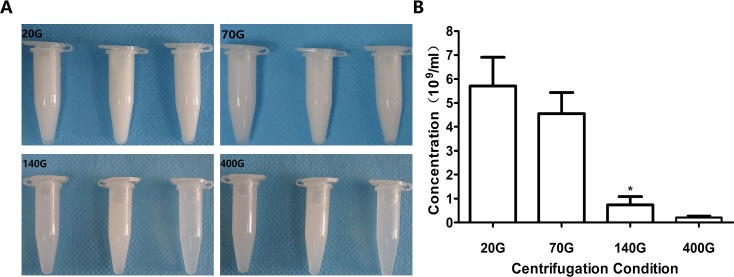
Concentration of nanobubbles at different centrifugation speeds of 20 g, 70 g, 140 g, and 400 g. (A) Photos of nanobubbles produced by different centrifugal speed. (B) Quantitative analysis of centrifugation of different nanobubbles. *P < 0.05 compared with 20 g.